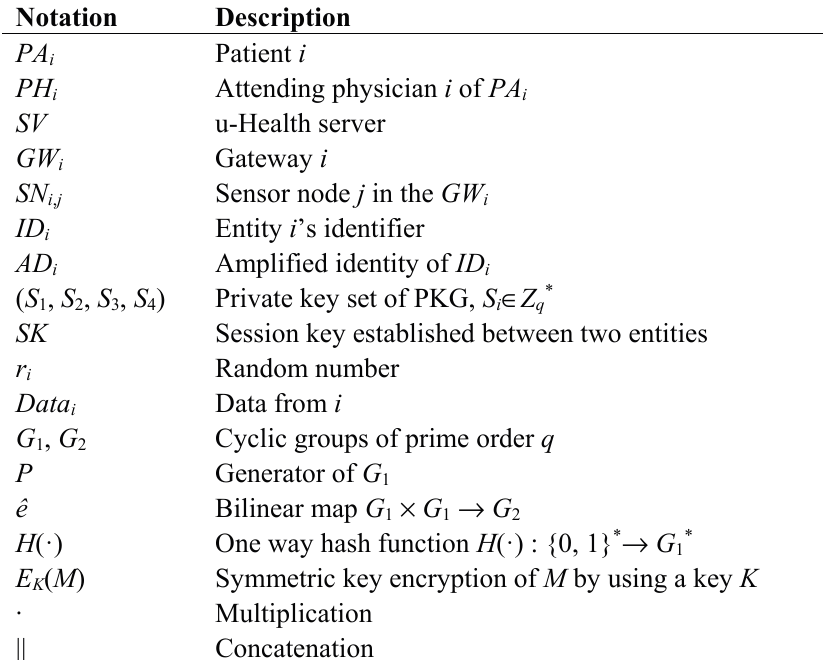
Table 1. Notations.